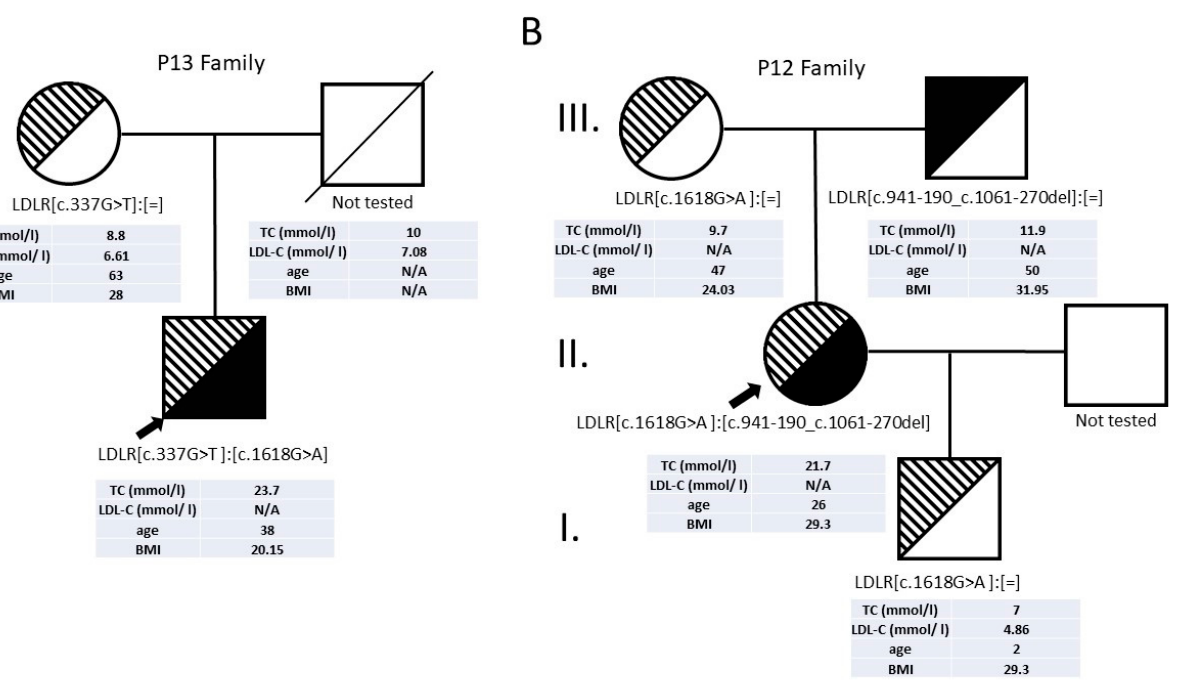
Figure 2. Pedigree of patients 13 and 12. ( A ) Patient 13 family members. The father of the proband could not be tested. ( B ) Patient 12 family members. Three generations were